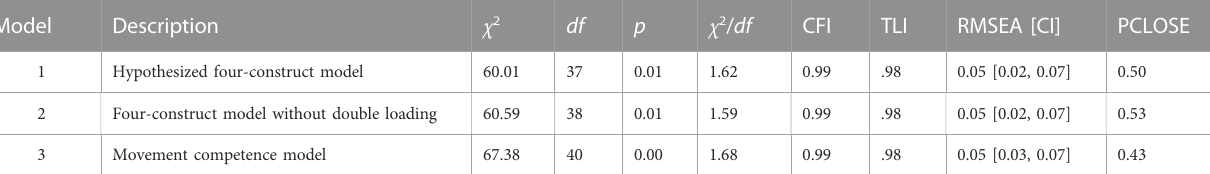
TABLE 2 Fit indices of each speci fi ed